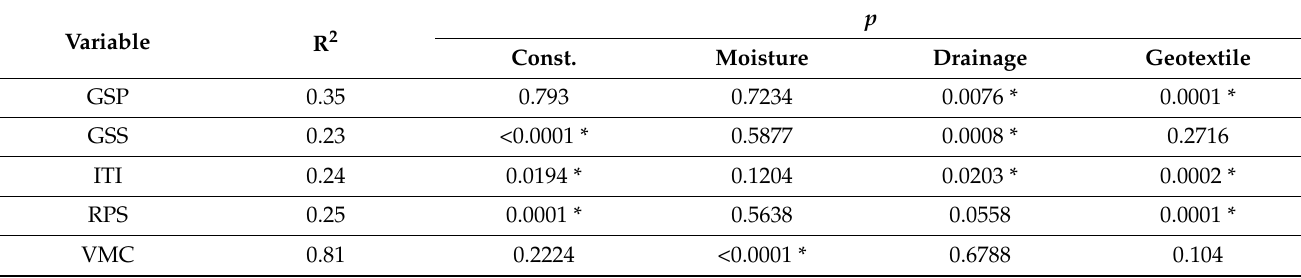
Figure 7. Mean of double interaction moisture x geotextile for GSP (in N) M 1: GMC was 11.16% ± 2.93 and treatment; M2: 21.60% ± 10.90; G1: without geotextile; G2: with 2 kg/m 2 of geotextile. The stars (*, **) indicate significative statistically differences. Table 4. Regression coefficients (R 2 ), constant and signification of each linear model for every variable GSP, GSS, ITI, RPS and